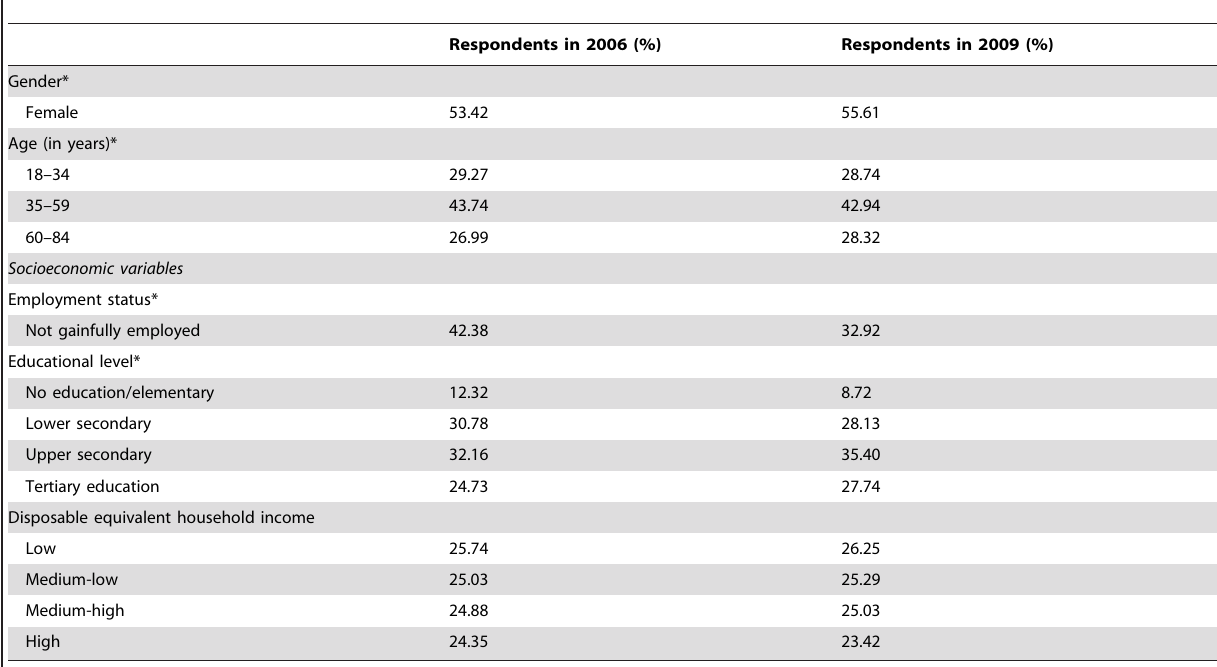
Respondents in 2006 (%) Respondents in 2009